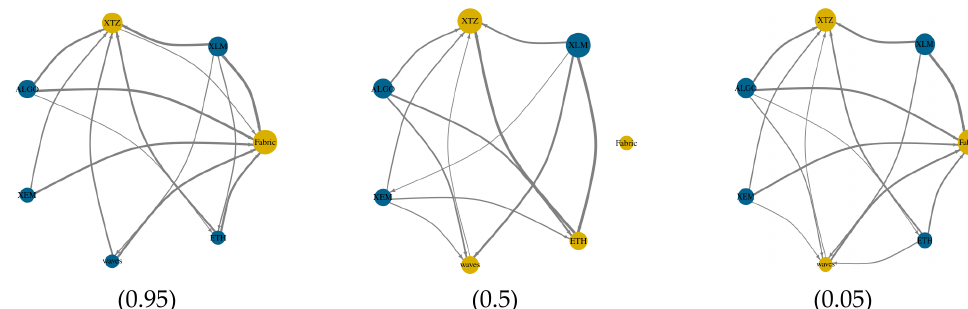
Figure 3. Network plot at three quantiles (0.95, 0.5, and 0.05). Figure 4 presents the total connectedness index across the quantiles. Risk spillover/connectedness is the lowest around normal circumstances ( Q = 0.5) and sharply increases in the stressed periods (represented by Q = 0.05 and 0.95).